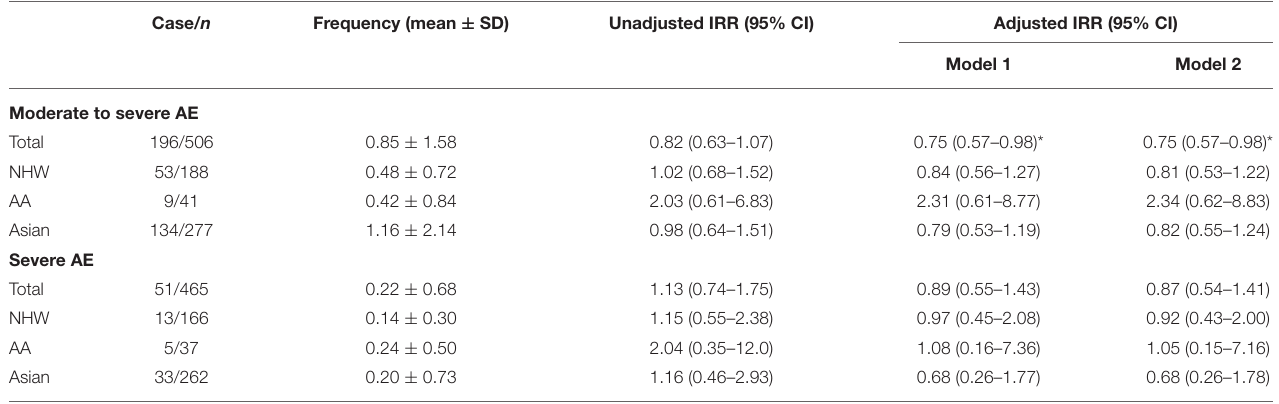
TABLE 4 | Effects of ICS on risk for exacerbation during 1-year follow-up in patients with